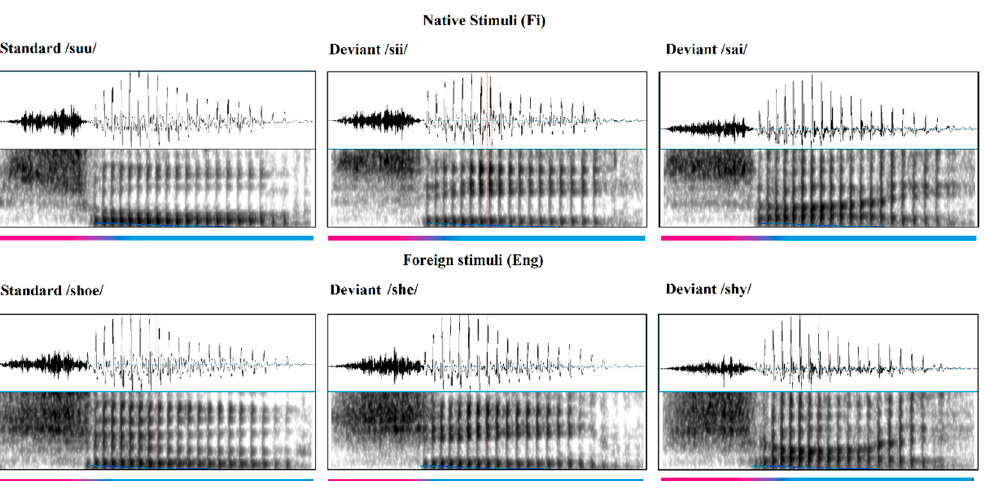
Figure 1. Spectrograms of the stimuli used in the oddball paradigm. At the top are the native (Finnish) stimuli and at the bottom are the foreign (English) stimuli. The color bar below shows the sound change from the fricative (in pink) to vowel(s) (in blue) at around 120 ms.